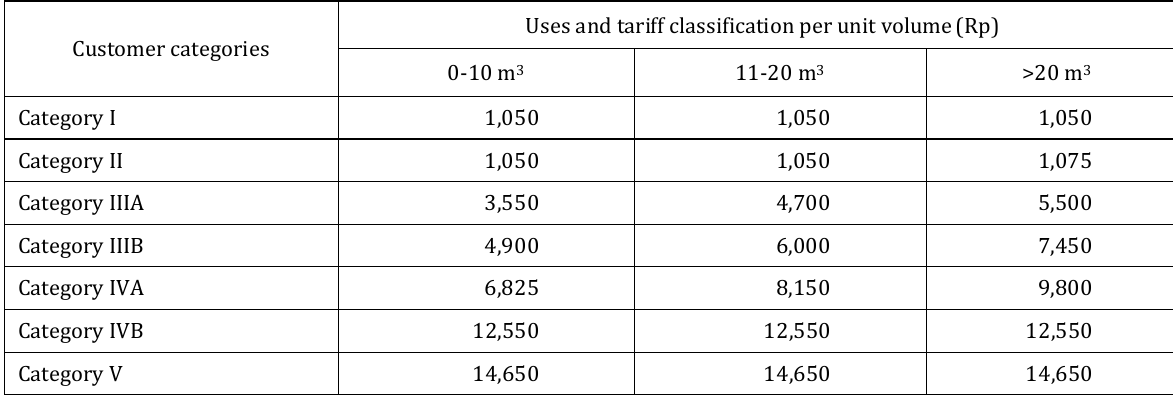
Table 3. Customer Categories and Water Tariffs in Jakarta (Governor Office DKI Jakarta, 2007)